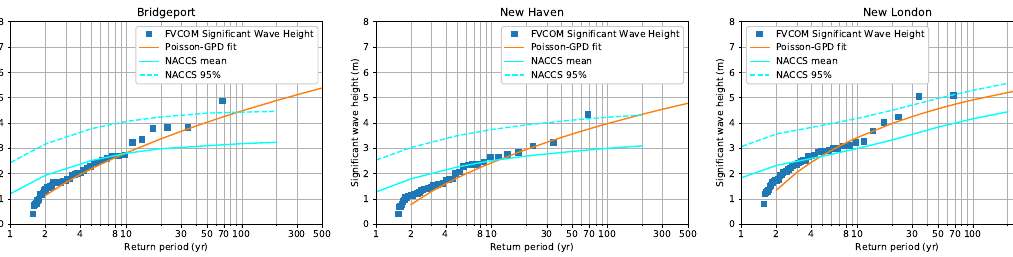
Figure 7. The water level and return period plots for Bridgeport, New Haven, and New London.